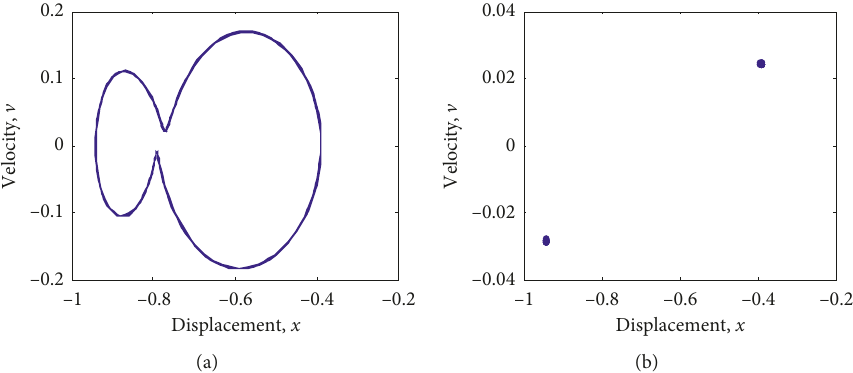
Figure 11: Dynamic response of the system at ω � 0.5. (a) Phase diagram. (b) Poincar´e